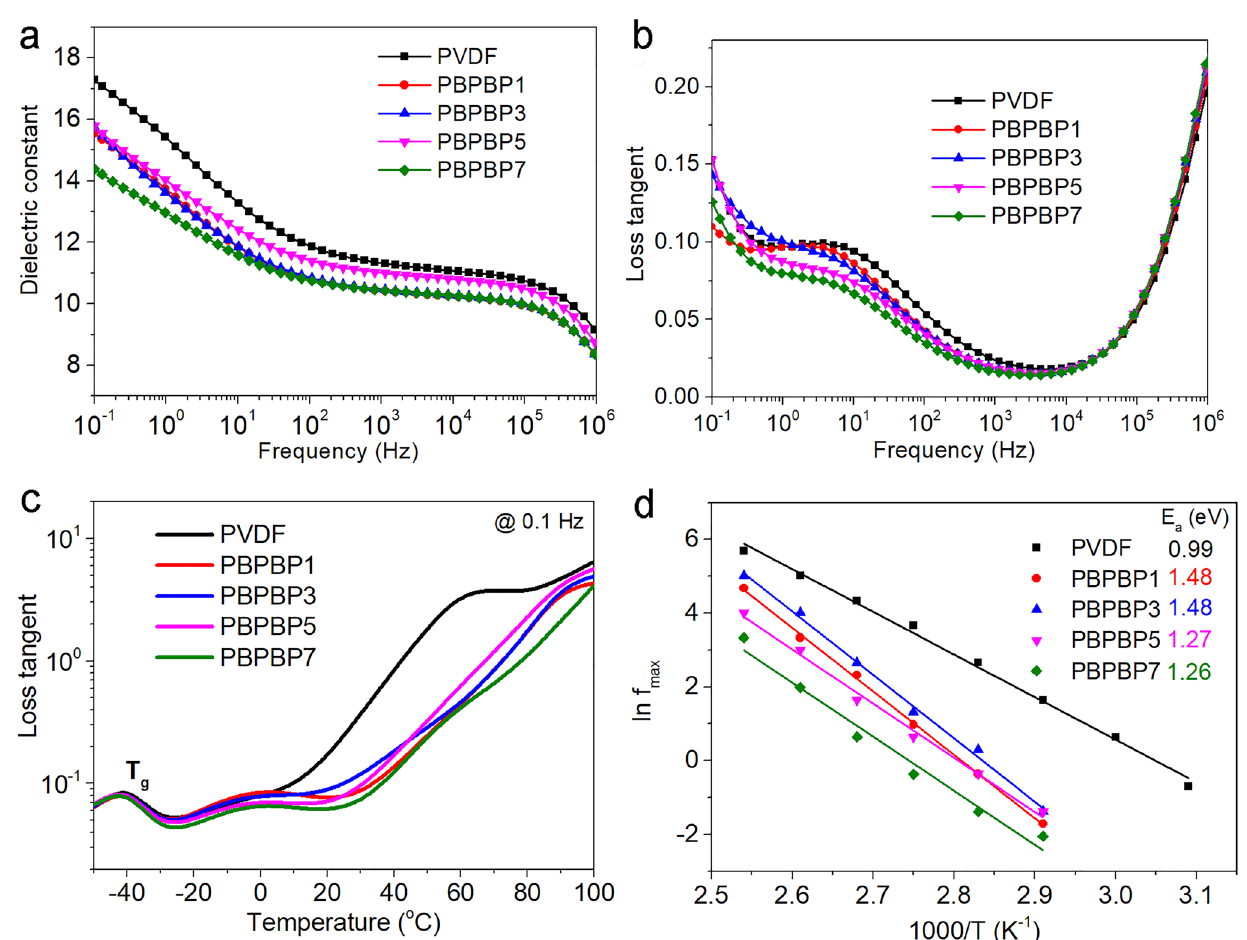
Fig. 3 Frequency dependency of a dielectric constant and b loss tangent (tan δ ) of PVDF and PBPBP films. Comparison of c loss tangent (tan δ ) at 0.1 Hz under various temperature and d activation energy derived from Arrhenius plots (ln f max vs. 1/ T ) of PVDF and PBPBP